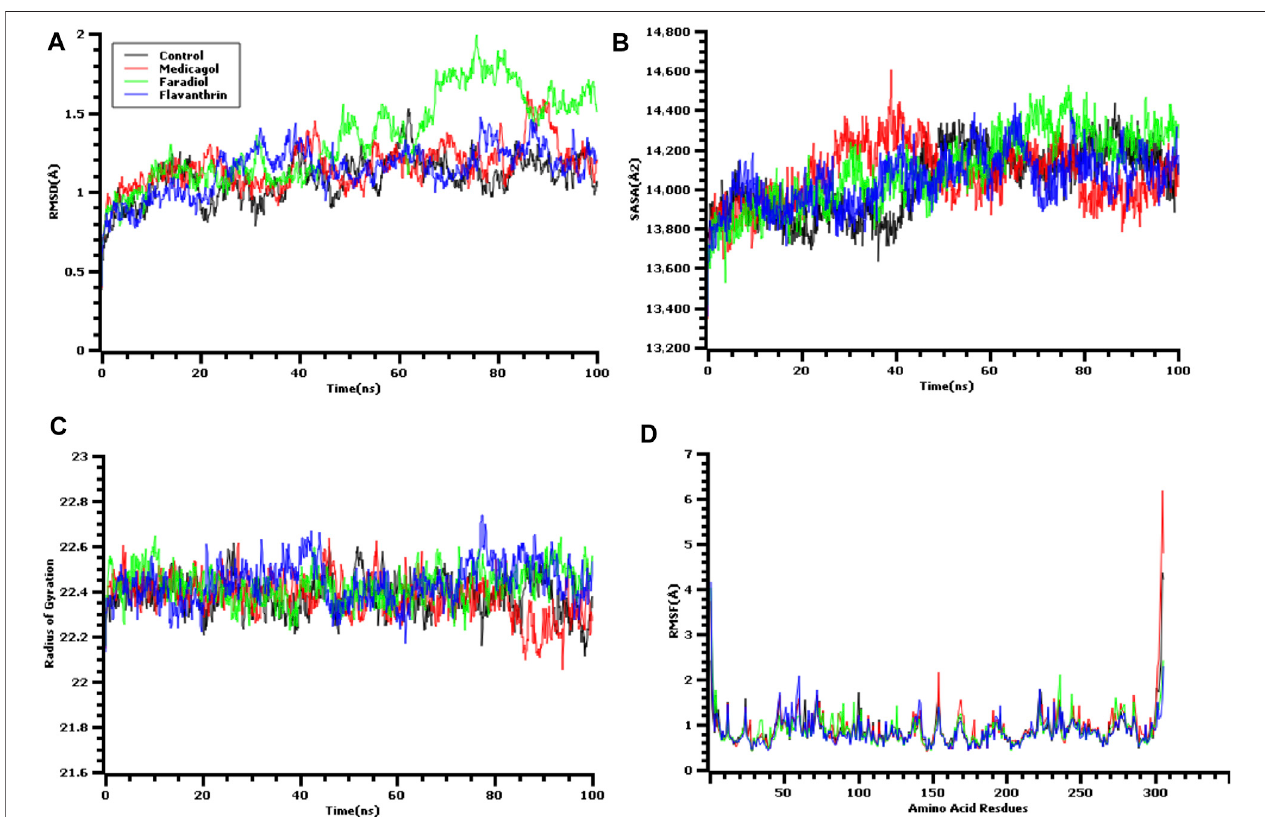
FIGURE 3 | Time series analysis of all simulated systems. Panels from (A) to (D) indicate the RMSD analysis of alpha carbon atoms (A) , protein volume with expansion analysis (B) , degree of rigidity and compactness analysis (C) , and fl exibility analysis of amino acid residues (D) .